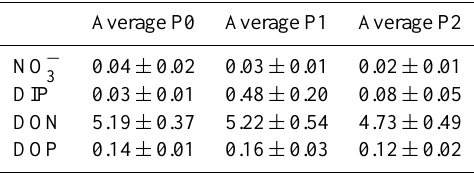
Table 3. Average NO − , DIP, DON, and DOP concentrations 3 (µmolL − 1 ) measured over the P0, P1, and P2 periods. NO − and 3 DIP concentrations were determined using a segmented flow ana- lyzer according to Aminot and Kerouel (2007). The detection limit was 0.01 and 0.005µmolL − 1 for NO − and DIP, respectively. DON 3 and DOP concentrations were determined according to the wet ox- idation procedure described in Pujo-Pay and Raimbault (1994) and Berthelot et al.